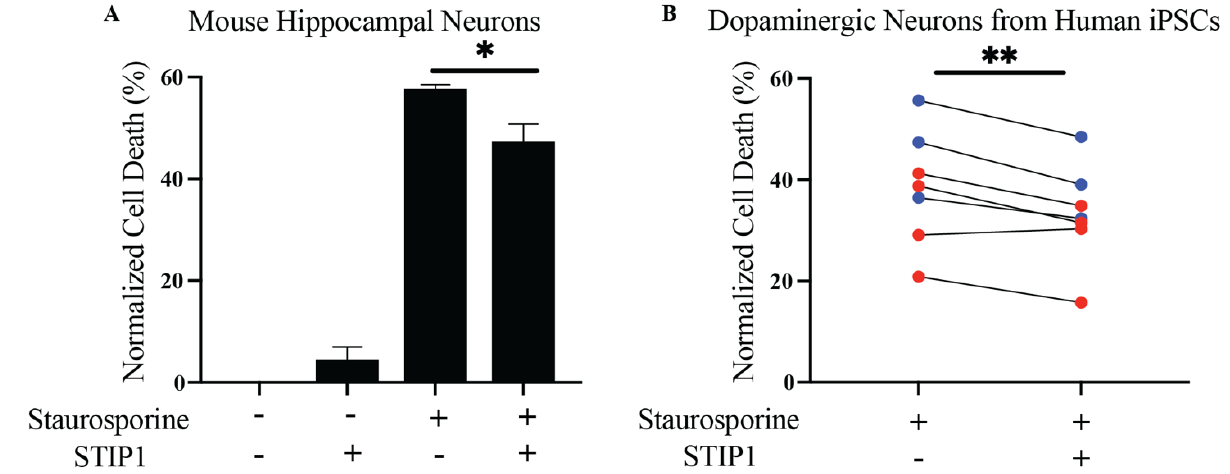
Figure 1. Human STIP1 ameliorates staurosporine-induced neurotoxicity in human dopaminergic neurons derived from induced pluripotent stem cells. Neurons were pre-treated with STIP1 over 1 h prior to staurosporine treatment over 16–20 h. Cell viability was quantified using the MTS assay and bar graphs are represented as the mean ± standard error of mean (SEM) percentage of cell death normalised against untreated neurons for each condition. ( A ) Primary mouse hippocampal neurons were treated with 1 μM mouse STIP1 followed by 31.25 nM staurosporine treatment. ( B ) Human induced pluripotent stem cells (hiPSCs) derived dopaminergic neurons from healthy (blue) and Parkinson’s disease (red) individuals were treated with 1 μM human STIP1 followed by 250 nM staurosporine. All experiments were independently repeated two to four times. Paired t -test analysis was performed for all samples except for the primary mouse hippocampal neurons, which was analysed using an unpaired t -test. * p < 0.05, ** p < 0.01. Table 1. Demographics of the